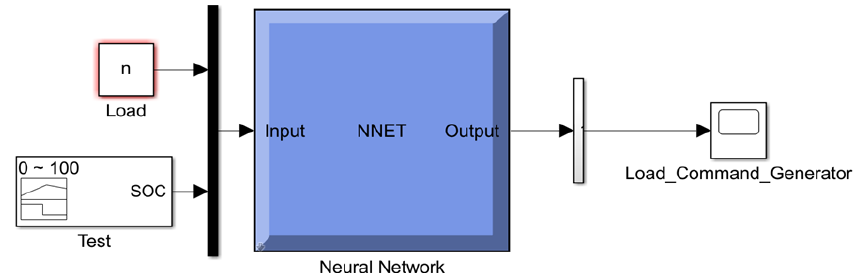
Figure 12. Verification model for proposed neural network controller.